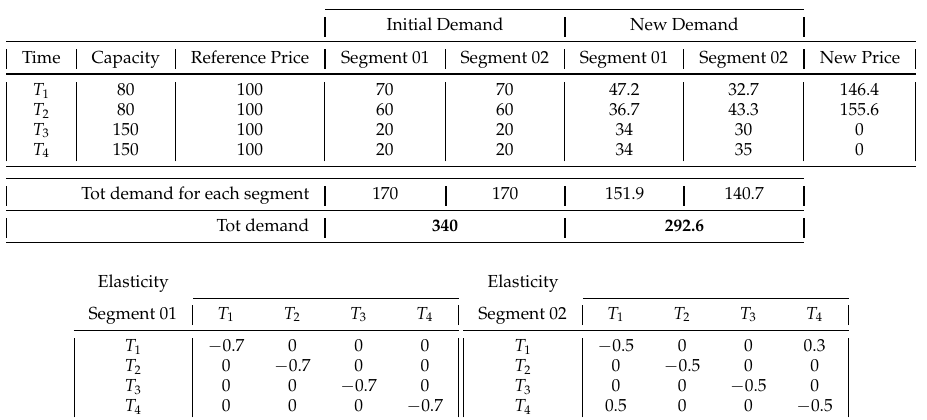
Table 8. Case Study 6.02—third sub-case, data, and